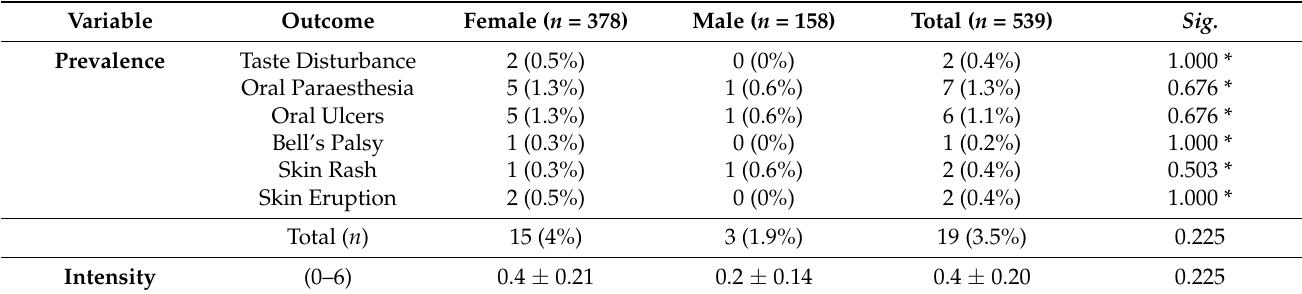
Table 5. Orofacial and skin-related side effects of young adults (18–30 years old) receiving mRNA-based COVID-19 vaccines, Czech Republic, April–June 2021 ( n = 539).